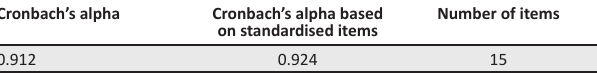
TABLE 1: Reliability of statistics.